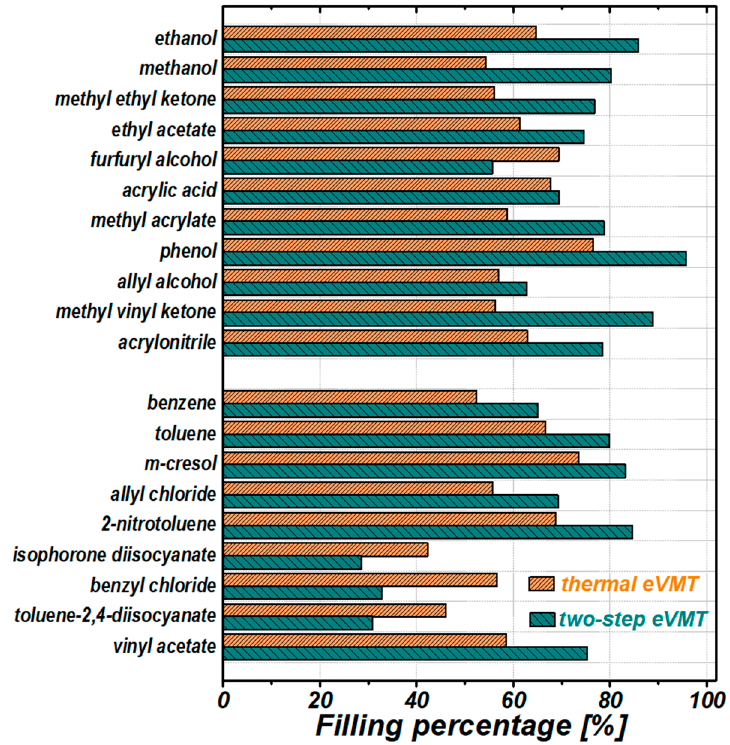
Figure 8. Horizontal bar charts displaying the filling percentage of a total pore volume of two-step and thermal eVMTs for various hazardous liquid chemicals.